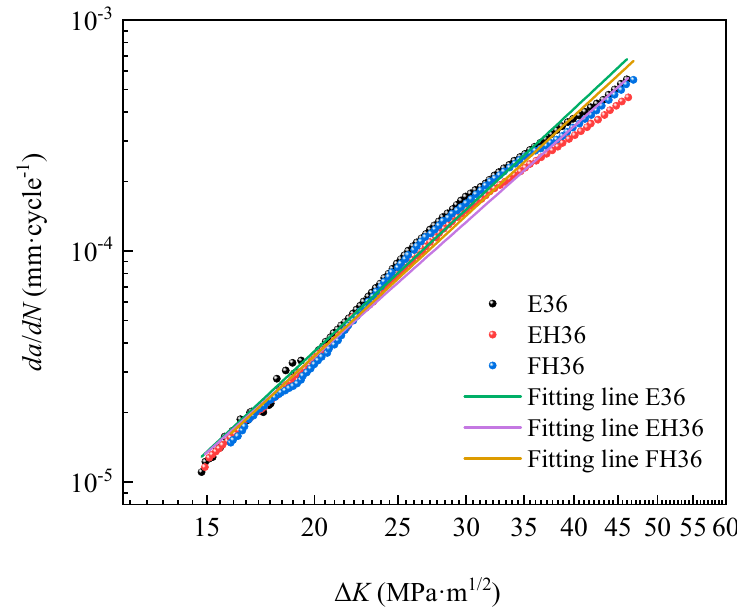
Figure 13. da / dN - ∆ K data points and fitting lines of the three grades of steel plate.